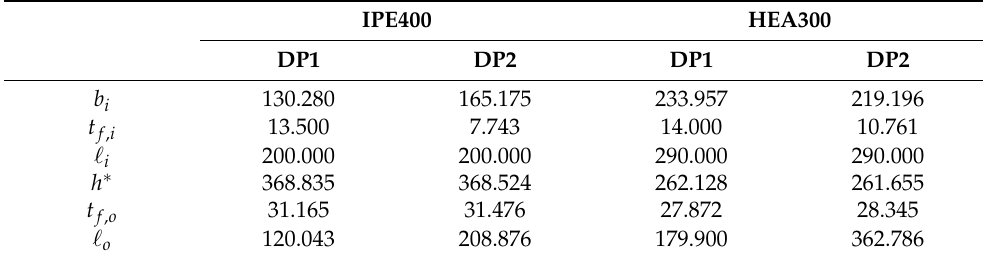
Table 4. Optimal designs (all dimensions are in